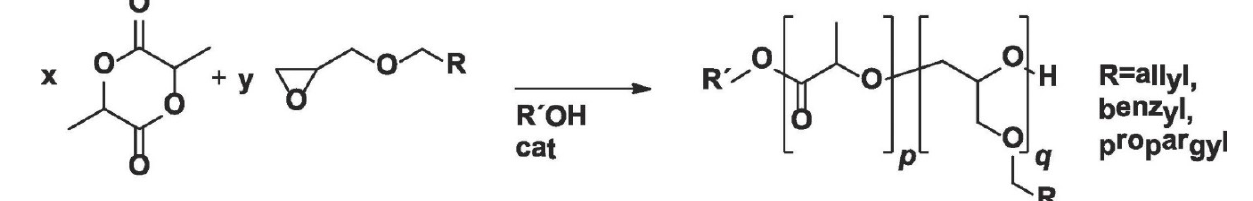
Figure 4. Introduction of allyl, benzyl, or propargyl functional group along a PLA chain via copolymerization of D,L-LA with glycidyl ethers as proposed by Pound-Lana et al. Reprinted with permission from [36]; published by Elsevier, 2017.